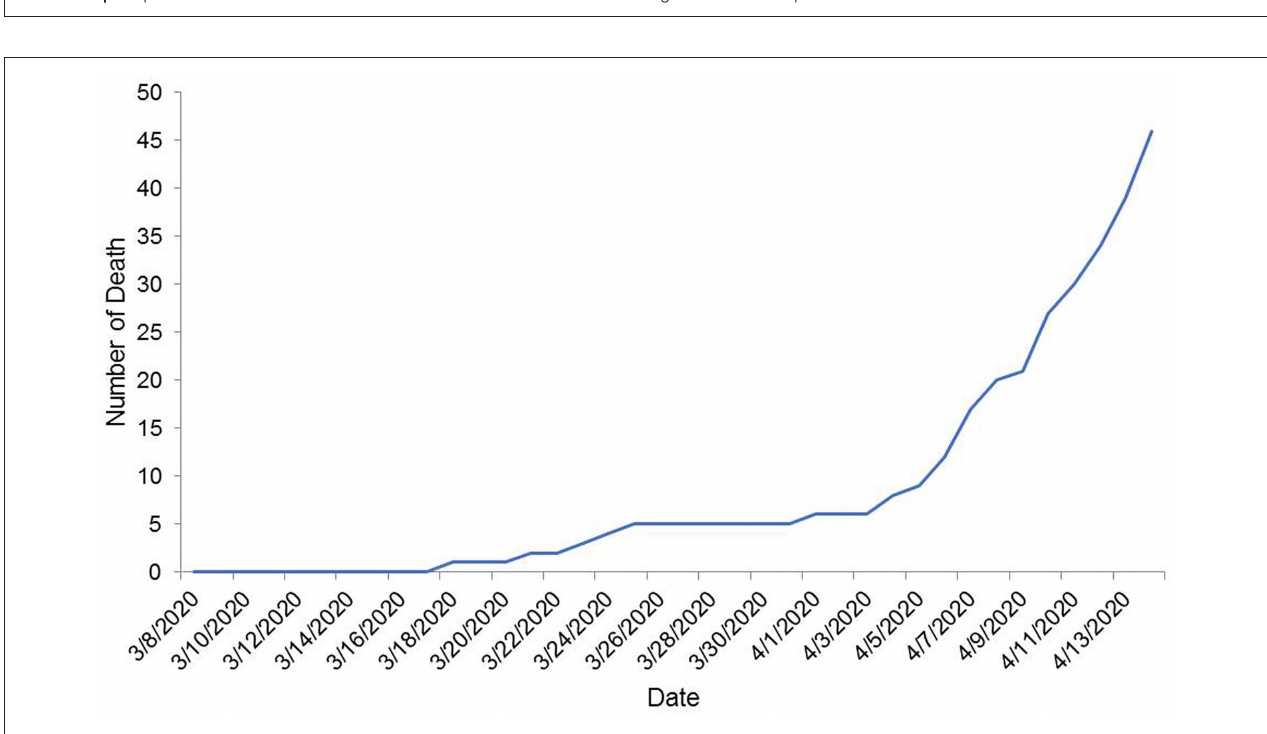
FIGURE 2 | Temporal distribution of the number of cumulative death due to COVID-19 in Bangladesh up to 14 April 2020.